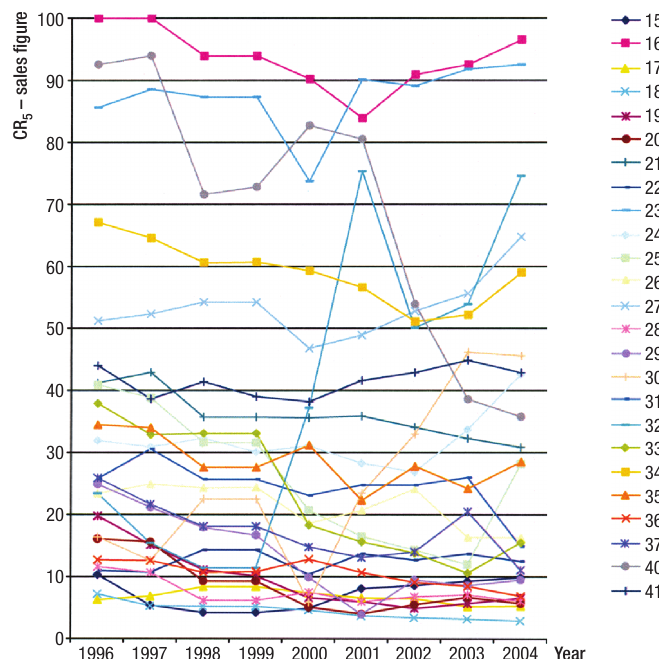
Fig. 2. CR evolution – sales fi gure during 5